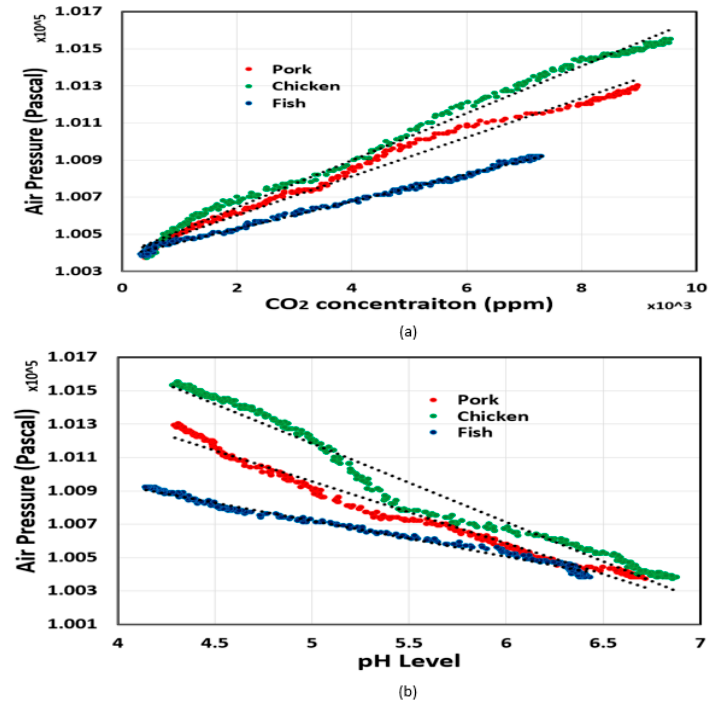
Figure 5. Correlation analysis ( a ) between air pressure and CO 2 concentration, and ( b ) between air pressure and meat pH level. In this experiment, the tested food was stored at room temperature.